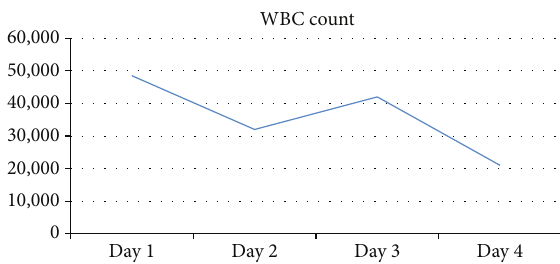
Figure 2: Progression of WBC count throughout the hospital